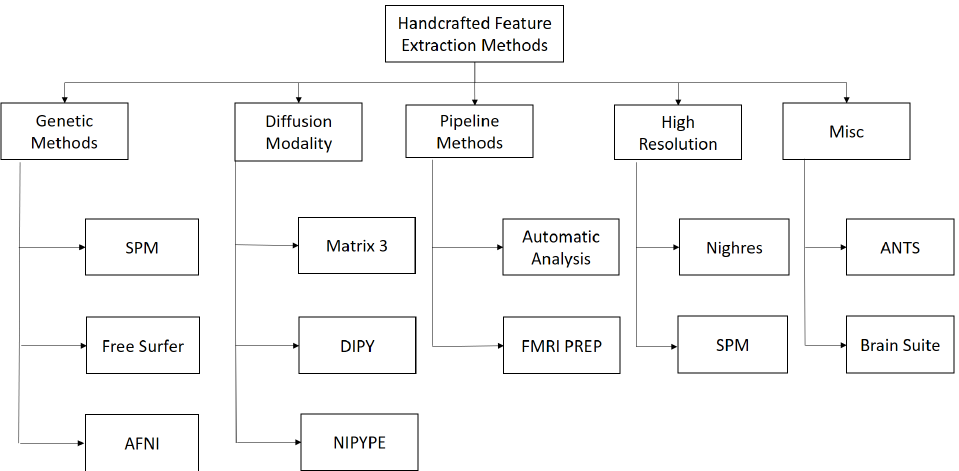
Figure 5. Organization for Handcrafted Feature Extraction Methods (Automated Pipeline methods).